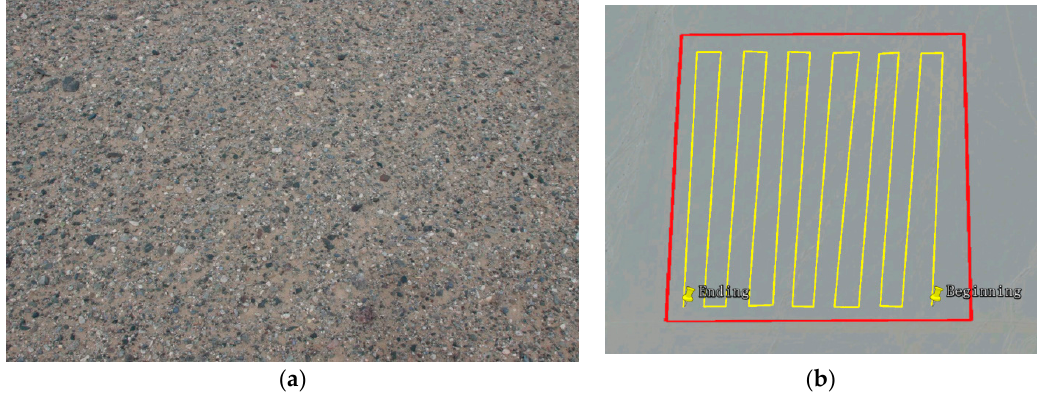
Figure 6. ( a ) Photo of the calibration site. ( b ) Schematic of the surface measurement route.